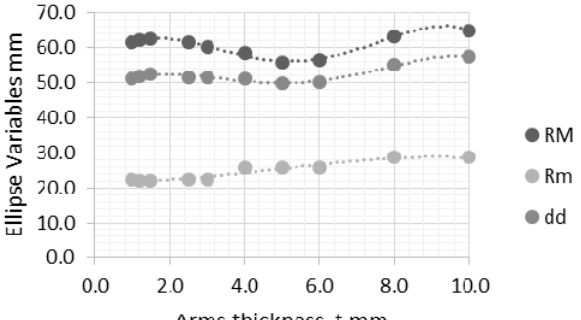
Figure 2: Pareto Fronts for several arms thickness Figure 3: Arms thickness influence on the elliptical fillet.